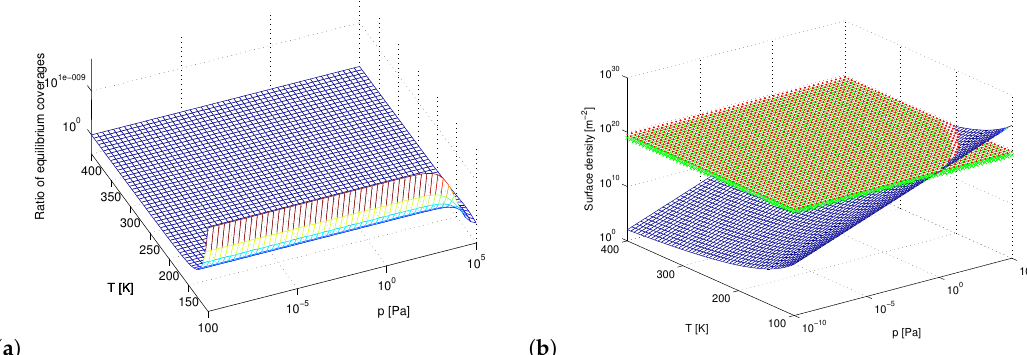
Figure 3. ( a ) The ratio of the adsorption capacities for the monolayer adsorption of carbon monoxide on graphene, calculated with and without neglecting the depletion of the number of the molecules in the gas phase. ( b ) Surface densities are calculated in three ways: based on the crystallographic surface of graphene (the plane with red dots), based on the molecular size and orientation (the plane with green plus symbols) and by using the expression from [40] based on the desorption energy (mesh).